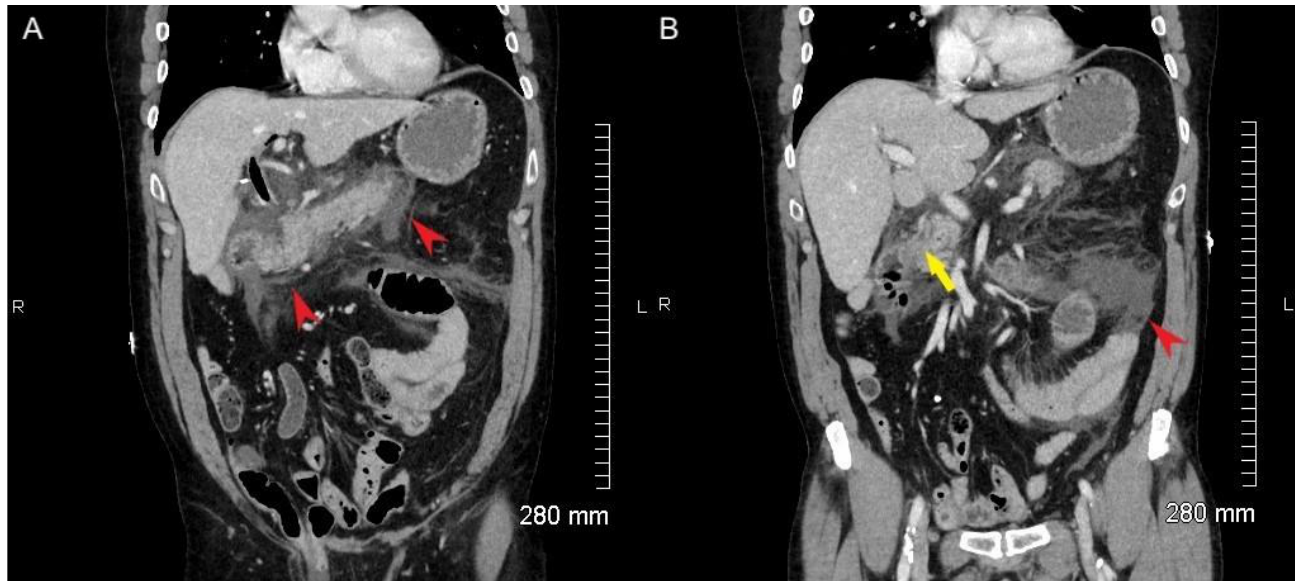
Figure 1. CT abdomen and pelvis with contrast demonstrates significant peripancreatic fluid and fat stranding extending to porta hepatis, consistent with acute pancreatitis ( A , B , red arrowheads). The patient is status post cholecystectomy. There is pneumobilia, likely associated with prior cholecystectomy. The biliary tree is prominent with abnormal wall enhancement. The CBD measures 9 mm proximally and 5 mm distally. No definite signs of choledocholithiasis are seen in the distal CBD ( B , yellow arrowhead).